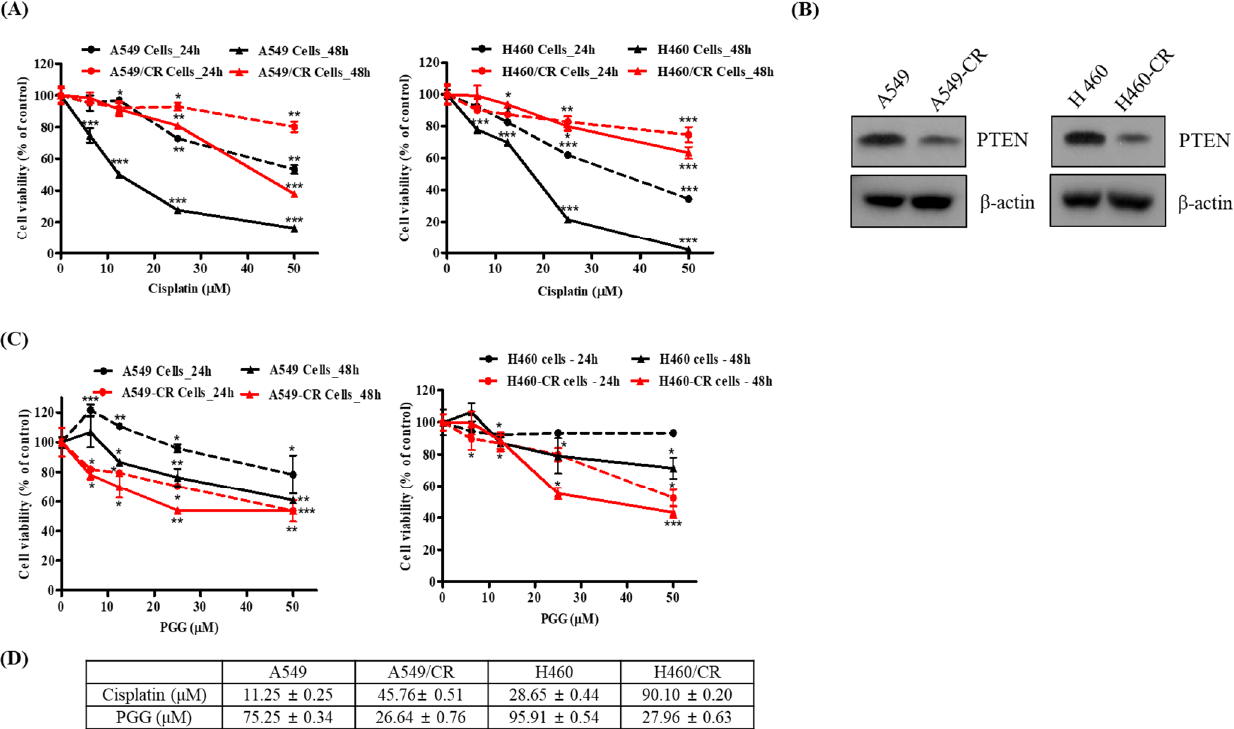
Figure 1. Effect of PGG on the viability and different endogenous PTEN levels in A549/A549CR and H460/H460CR cells. ( A ) Cisplatin-resistant NSCLC lines demonstrated an increased sensitivity to PGG in a cell viability test (MTT). Plots representing cell viability in A549 (shown in black) and A549/CR (shown in red) lines treated with cisplatin (at concentrations of 0, 6.25, 12.5, 25 and 50 μM) for 24 (dashed line) and 48 h (non-dashed line). *, p < 0.05, **, p < 0.01, ***, p < 0.001 vs. untreated control. ( B ) Different endogenous PTEN levels in A549/A549CR and H460/H460CR cells. ( C ) Effect of PGG on the viability of A549/A549CR and H460/H460CR cells. Three independent experiments were conducted. ( D ) IC50 values of cisplatin or PGG in A549/A549CR and H460/H460CR cells. Data represent means ± S.D.